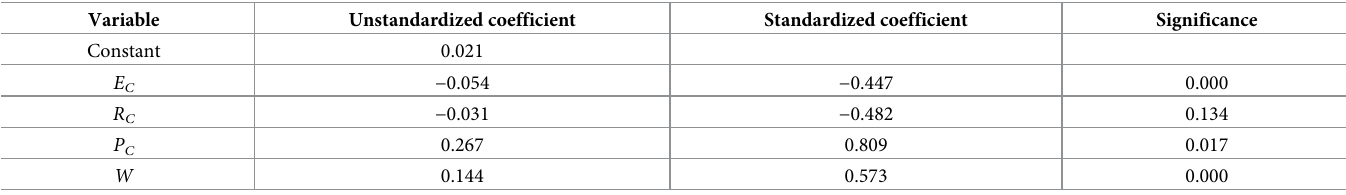
Table 8. QAP regression analysis about the adjacency matrix.